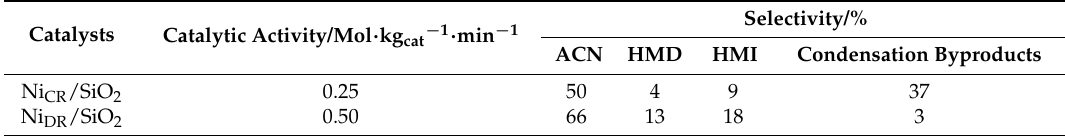
Table 4. Evaluation reaction result of Ni CR /SiO 2 and Ni DR /SiO 2 .